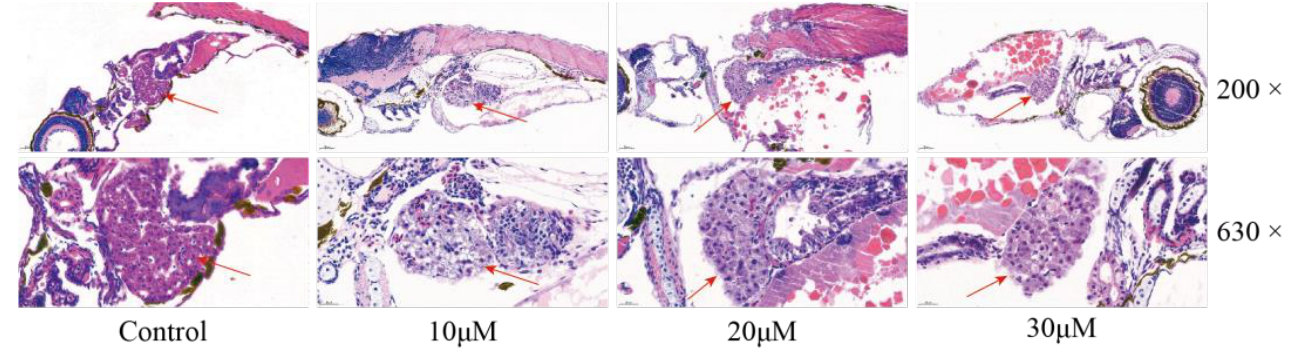
Figure 3. Effects of FRA on liver morphology. The liver is indicated with red arrows. Low-magnifi-